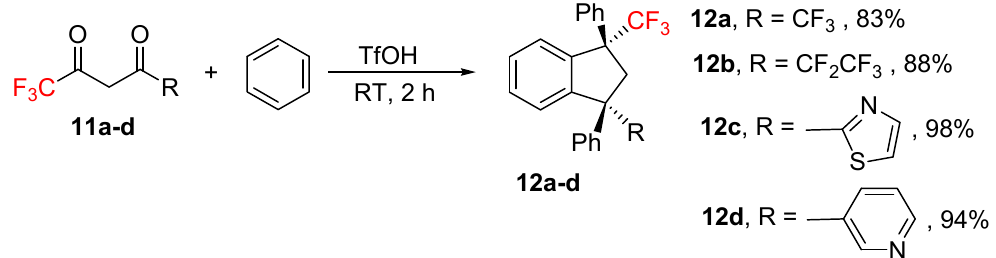
intermediate cations [25].